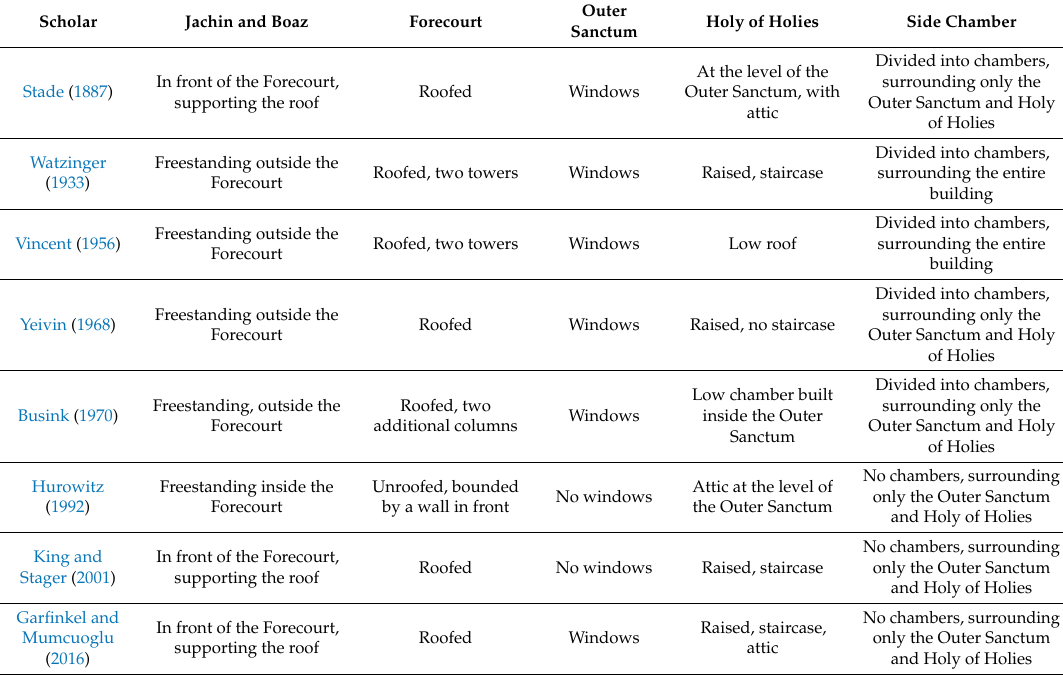
Table 1. Differences in opinion among scholars on architectural aspects of Solomon’s Temple.